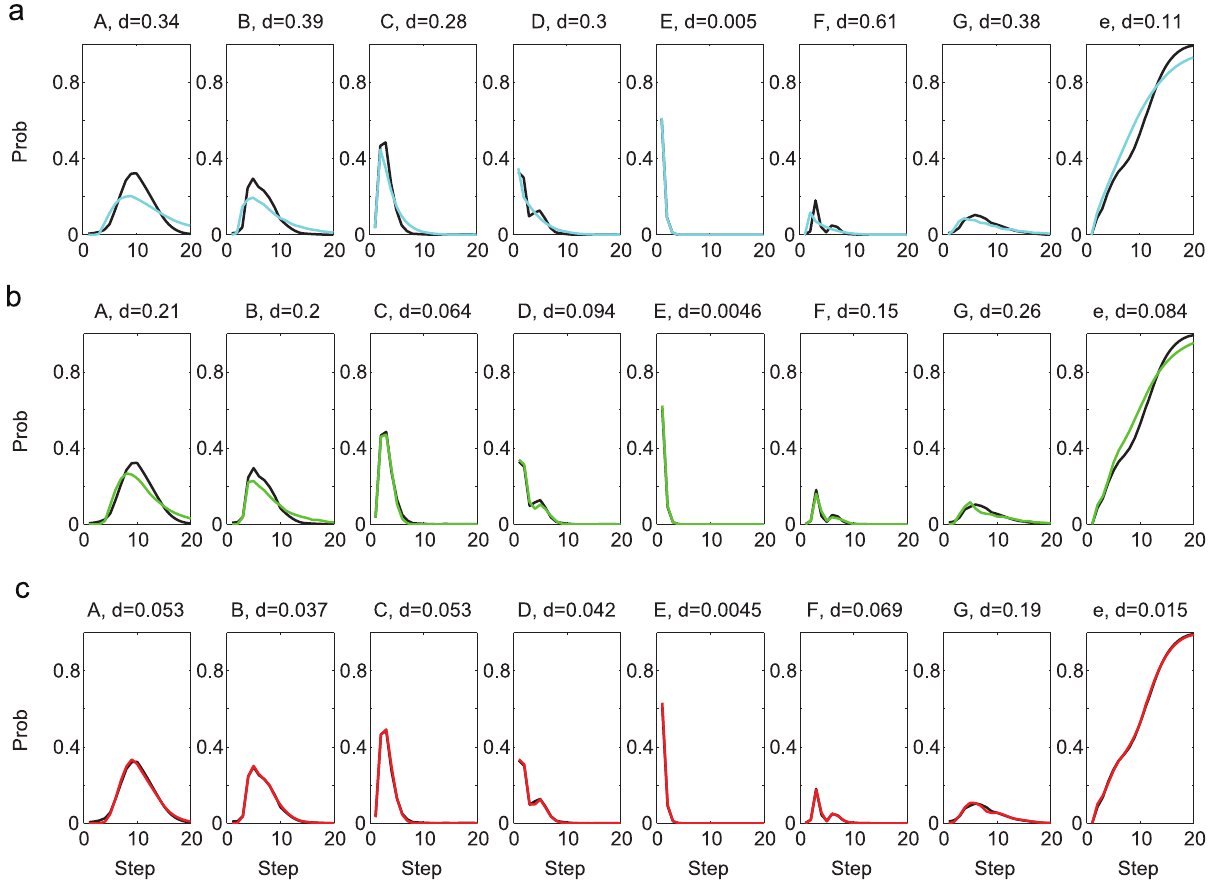
Figure 5. Comparisons of the probabilities of finding the syllables and the end (denoted with e) at a given step from the start (Bird 1). a . The Markov model. b . The Markov model with adaptation. c . The POMMA. The conventions are the same as in Figure 3.